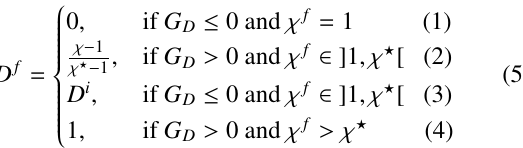
Table 1. Particles and contact law